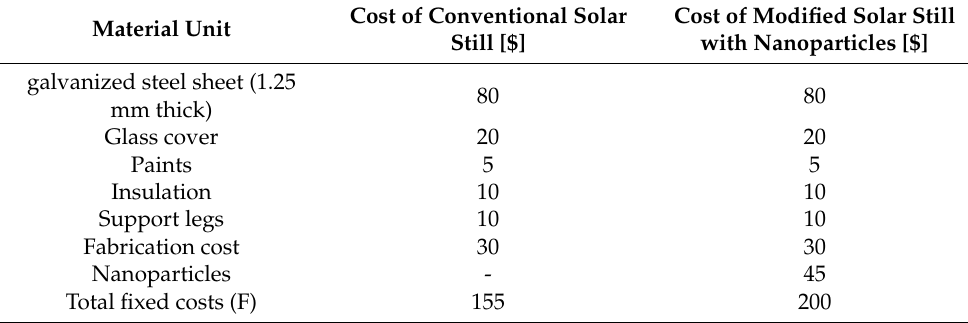
Table 1. The cost of the fabricated solar still. Material Unit